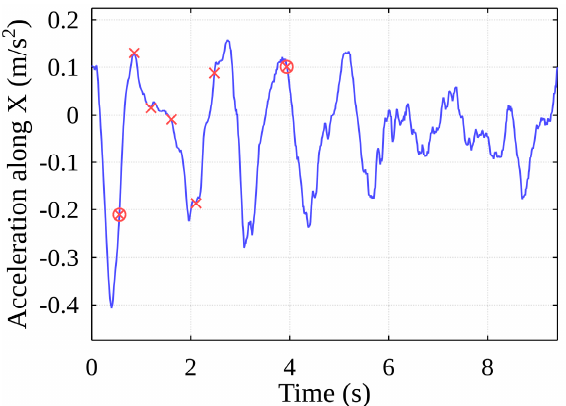
Figure 19. Potential events from unfiltered acceleration data.